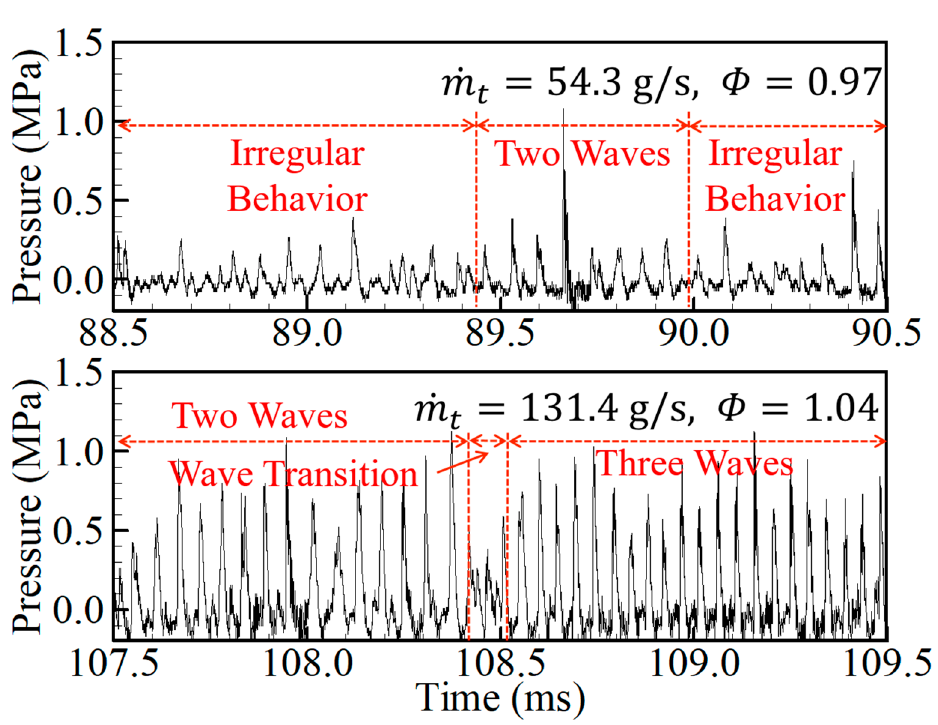
Figure 9. Pressure history shown in Figure 8a,d.